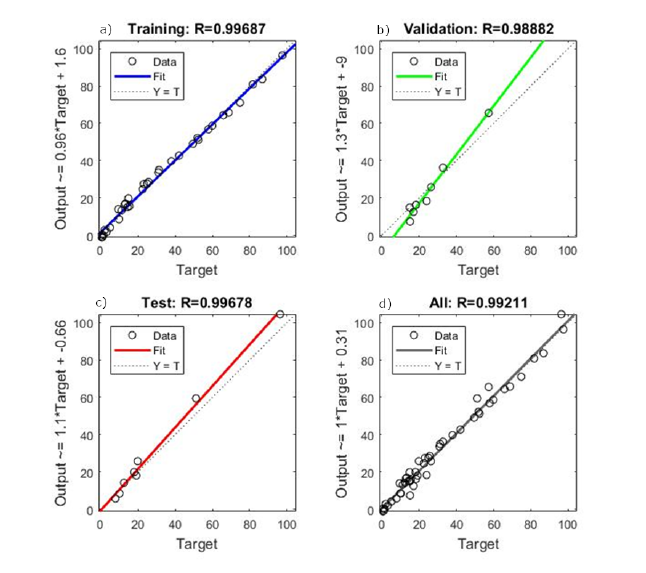
Figure 9. Regression and correlation for production using Matlab